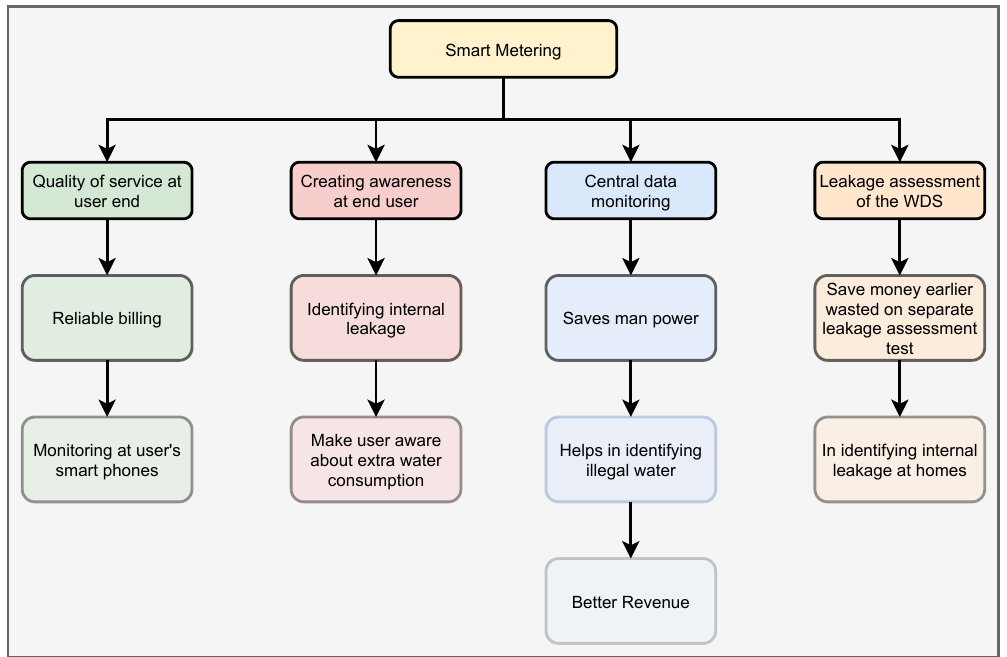
Figure 7. Smart metering applications and their